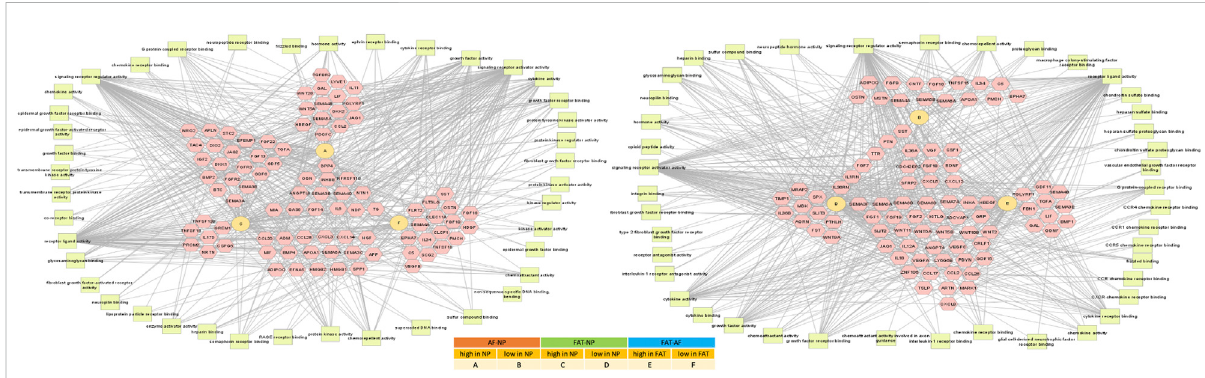
FIGURE 7 Network of differentially expressed transcripts between annulus fi brosus (AF) and nucleus pulposus (NP) cells of the IVD and adipose (FAT) stromal cells associated with the functional enrichment term signaling receptor regulator activity (GO:0030545). Networks were generated with